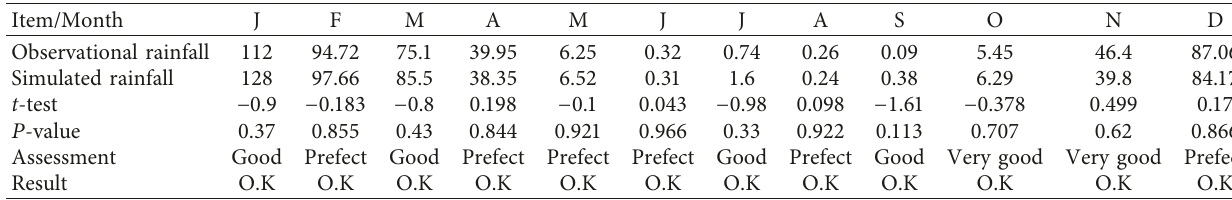
Table 4: Results of the t -test, comparison of the average monthly observational and LARS-WG simulated rainfalls of the Doroudzan station. Item/Month